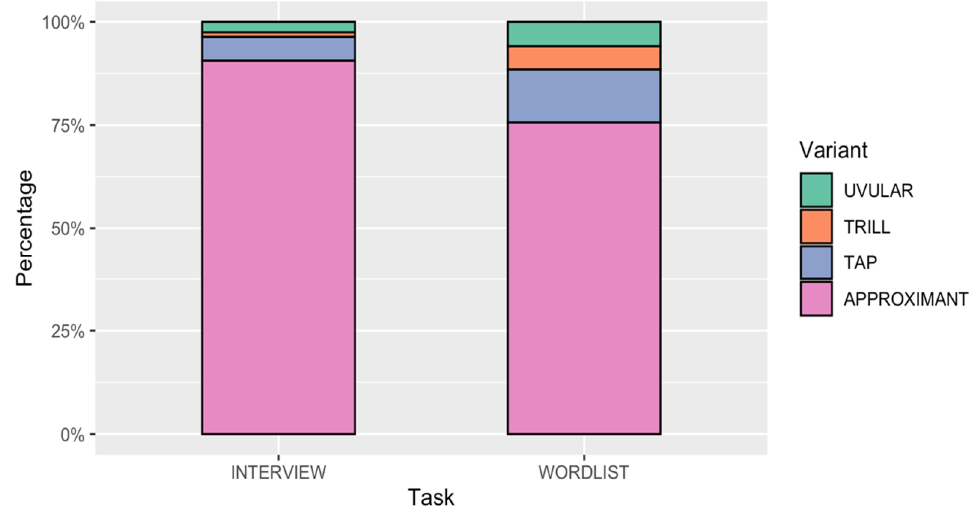
Figure 1. Distribution of /r/ variants in the Mold Welsh-language subset by task ( n = 754).